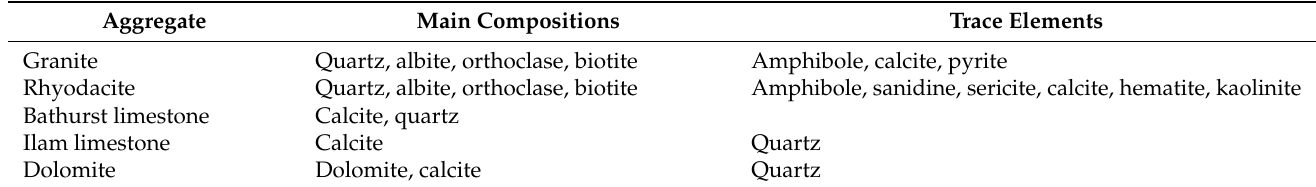
Table 1. X-ray diffraction results of different aggregates.